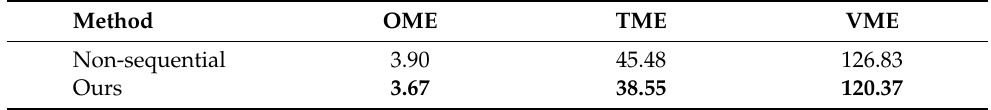
Table 7. Quantitative comparison between the non sequential framework and the proposed frame- work on the 3DPW dataset. The best results are shown in